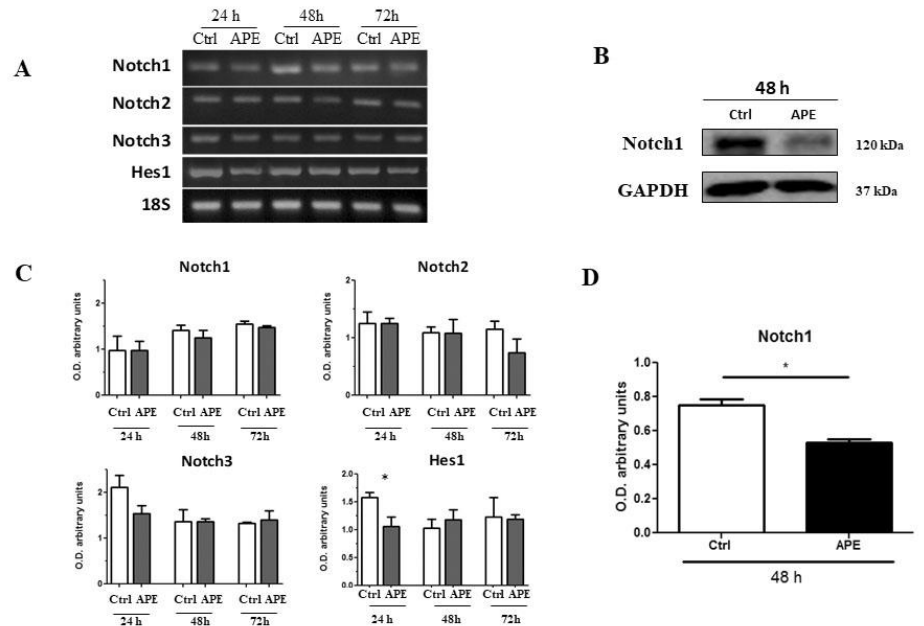
Figure 9. ( A ) RT-PCR analysis for Notch1, Notch2, Notch3, and Hes transcripts in GB7 cells. 18 S was used as a housekeeping gene. ( B ) Notch1 expression by Western blot analysis in GB7 cells. GAPDH was used as the internal reference protein. ( C ) Densitometric analysis of the RT-PCR bands indicated in Figure A normalized with the bands of housekeeping gene 18 S. The data are the average ± SEM of three independent experiments. ( D ) Densitometric analysis of Notch1 immunoreactive bands; Western blot normalized with the bands of the reference protein GAPDH. The data are the average ± SEM of three independent experiments (* p < 0.05 t-test).